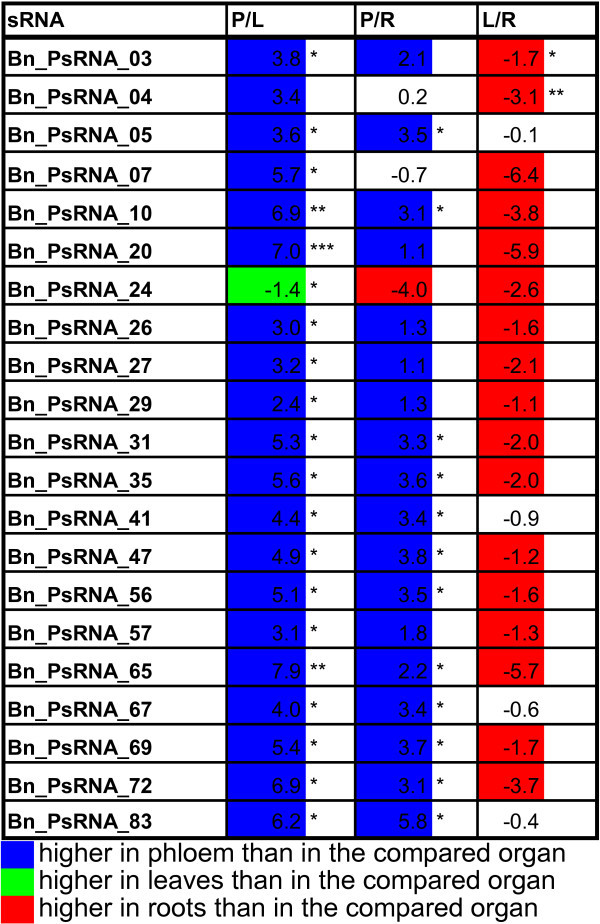
List of unknown sRNAs that were organ-enriched grown under full nutrition. List of unknown sRNAs, sequenced from Brassica phloem sap [1], that showed statistically significant differences between phloem sap, leaves and roots, respectively (p < 0.05, n = 3). Values are log2s between P/L: phloem vs. leaves, P/R: phloem vs. roots and L/R: leaves vs. roots. Markedly (log2 values >1 or <-1, indicating a two-fold difference) phloem-enriched miRNAs are marked in blue, leaf-enriched in green, and root-enriched in red. The statistical significance is indicated as: * p < 0.05; ** p < 0.01; *** p < 0.001.